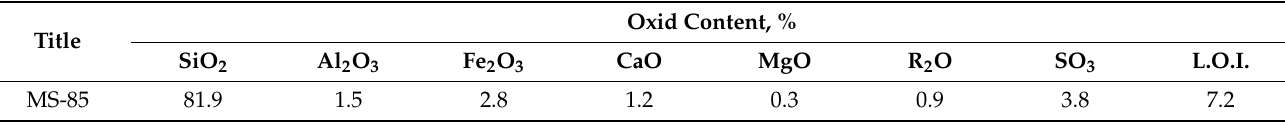
Table 8. Chemical composition of micro silica.